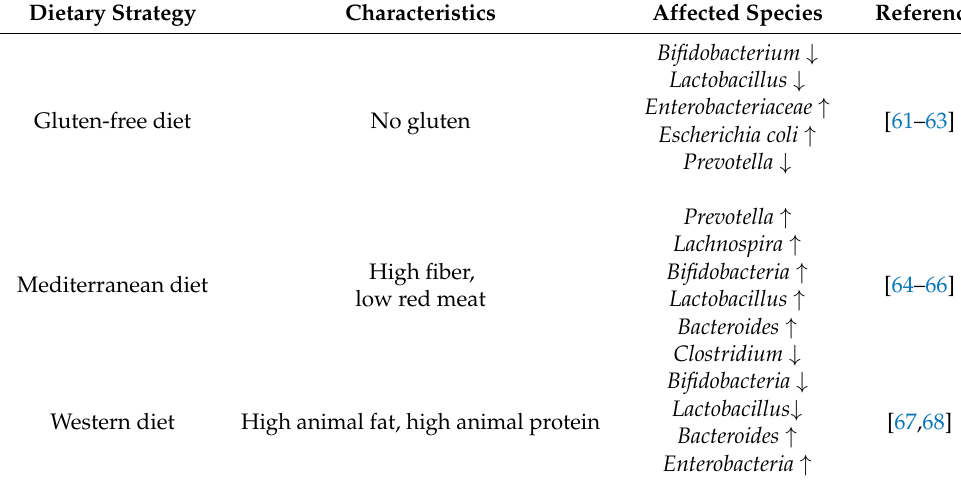
Table 1. Effects of diet on gut